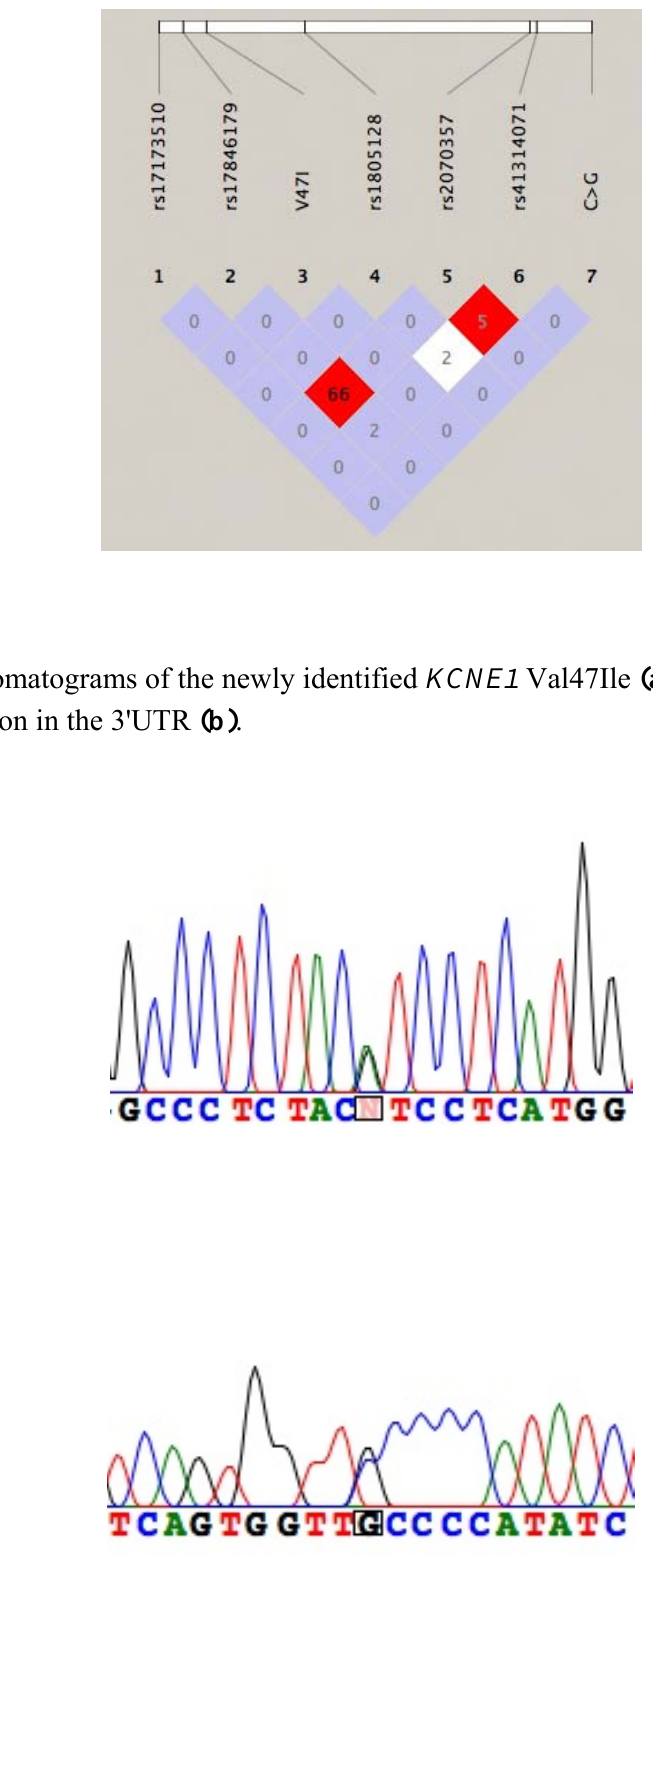
Figure 1. LD plot and R 2 values for the seven KCNE1 variants identified.